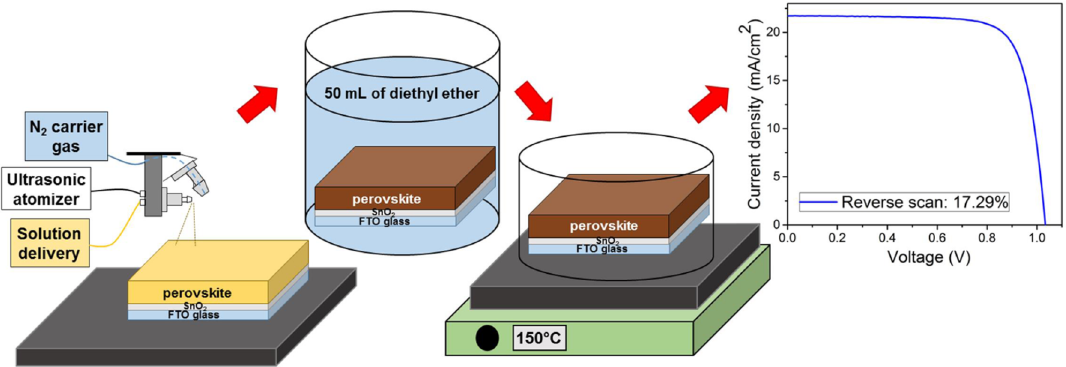
Figure 11. Fabrication of perovskite solar cells (PSCs) with spray-coating and PSC samples. Reprinted from ref. [35].